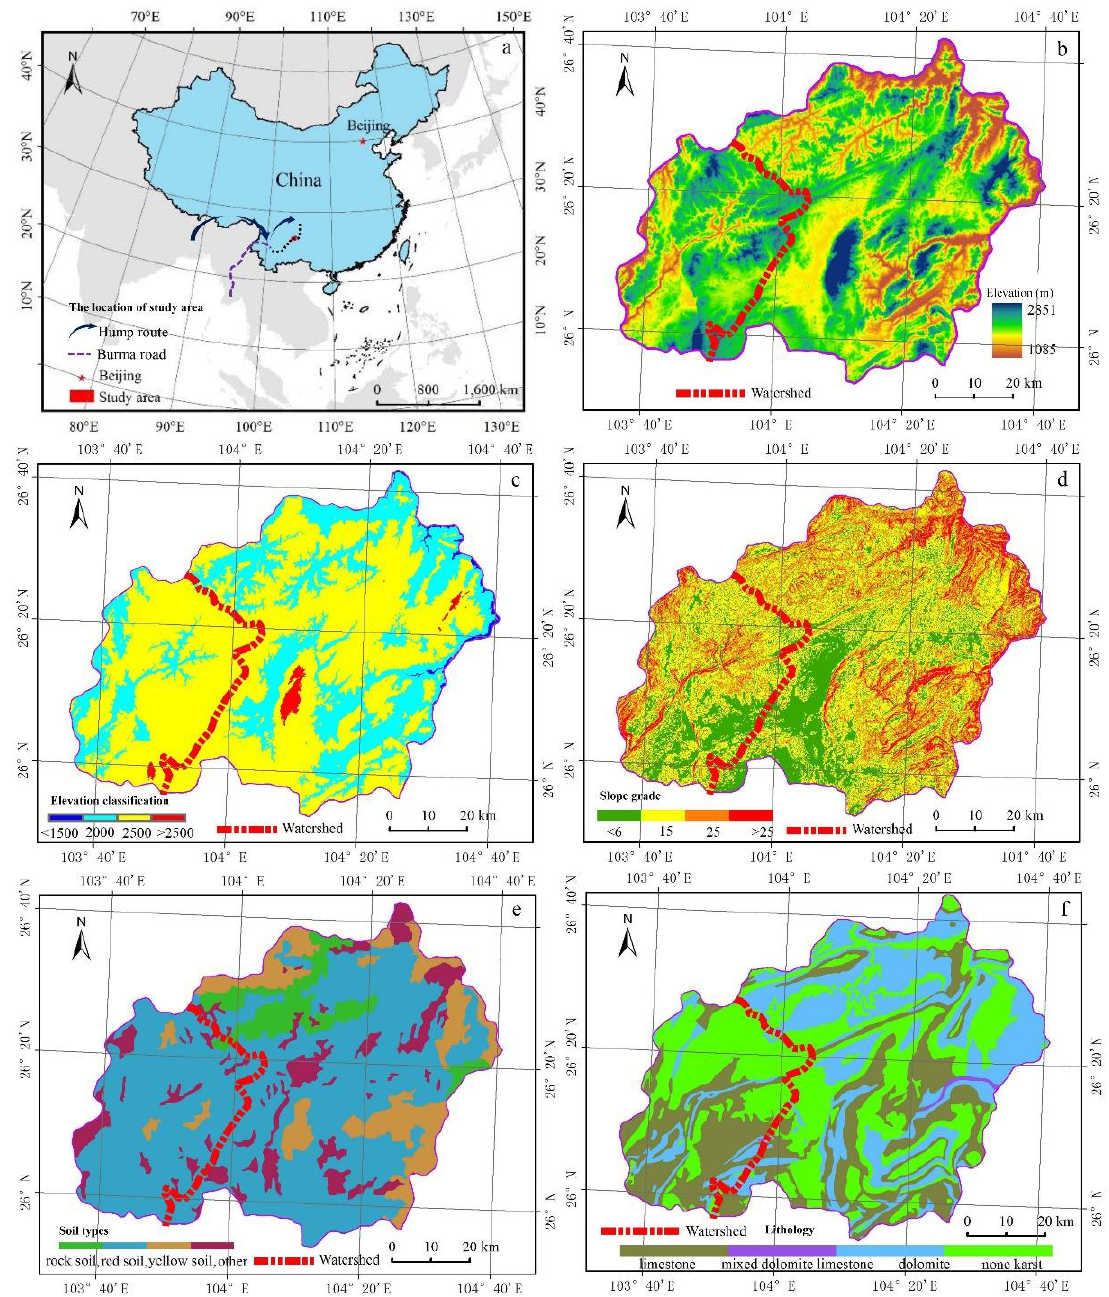
Figure 1. The maps of the location and main natural background of the study area. Note the following: ( a ) location; ( b ) elevation; ( c ) elevation classification; ( d ) slope grade; ( e ) soil type; ( f ) lithology. (We constructed this map using ArcGIS9.3 (http://www.esri.com/arcgis/about-arcgis) (accessed on 12 November